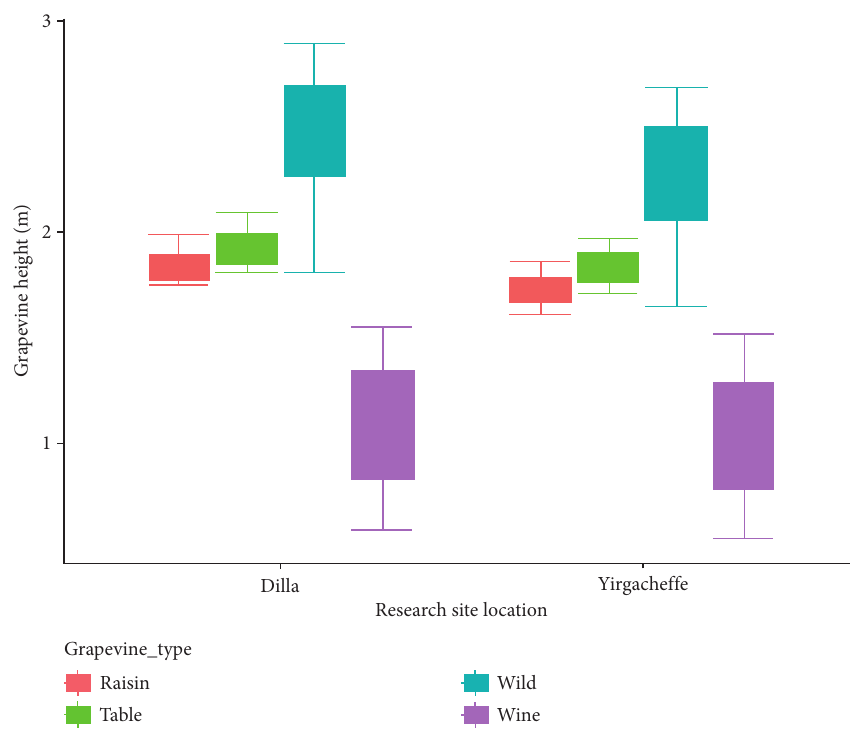
Figure 2: Response of plant height to grapevine cultivar types and research site